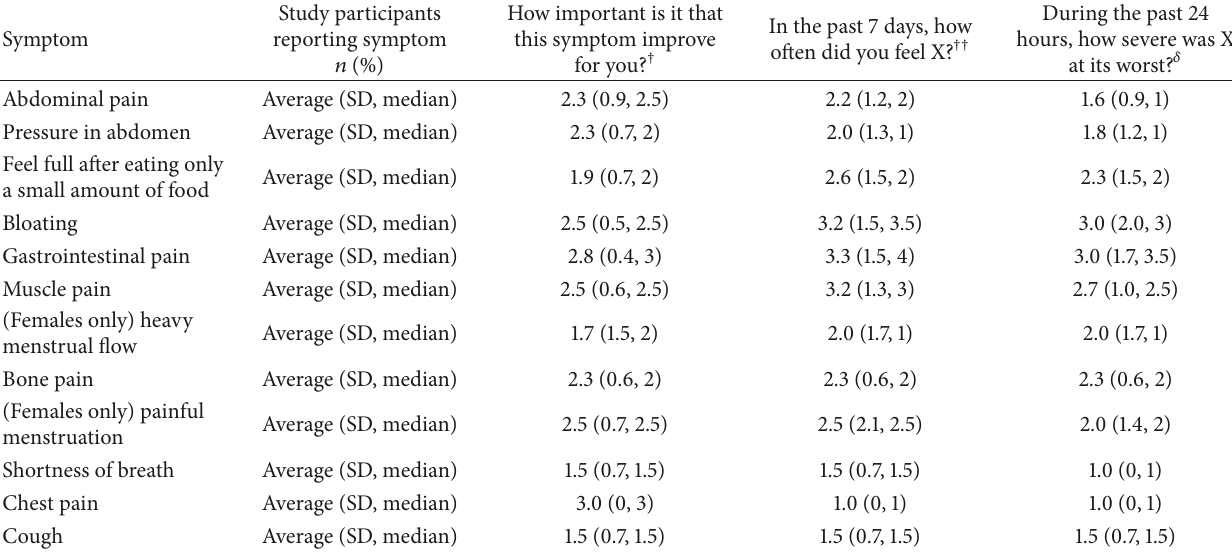
Table 3: Web survey results for symptom frequency and